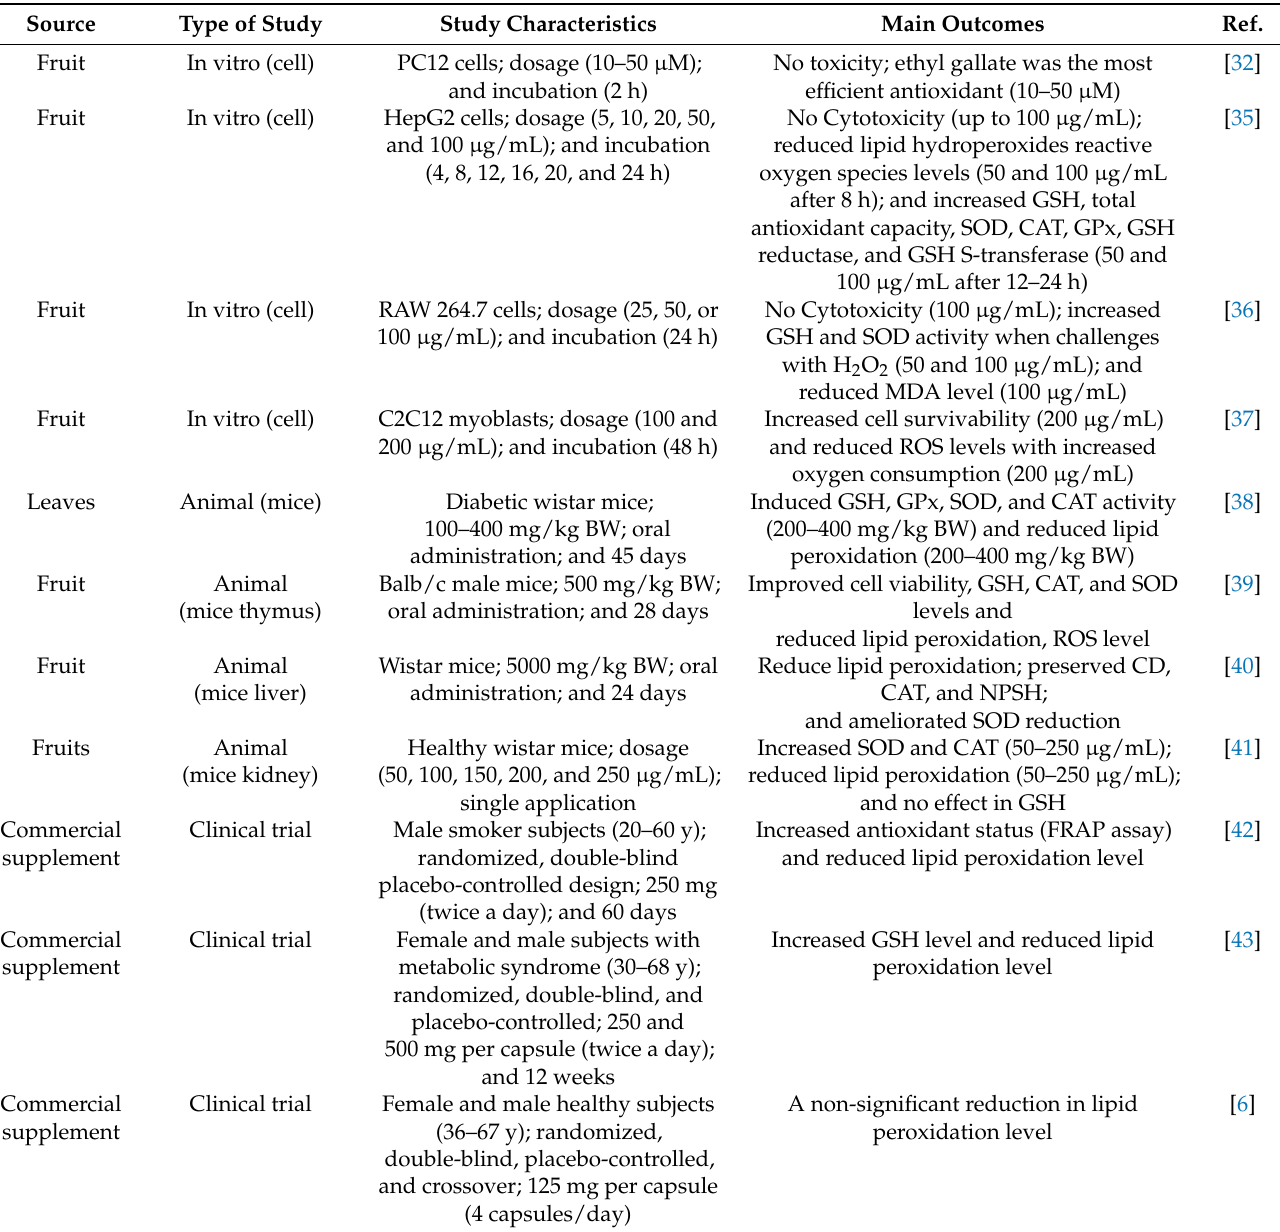
Table 2. Antioxidant effect and induction of endogenous antioxidant defense